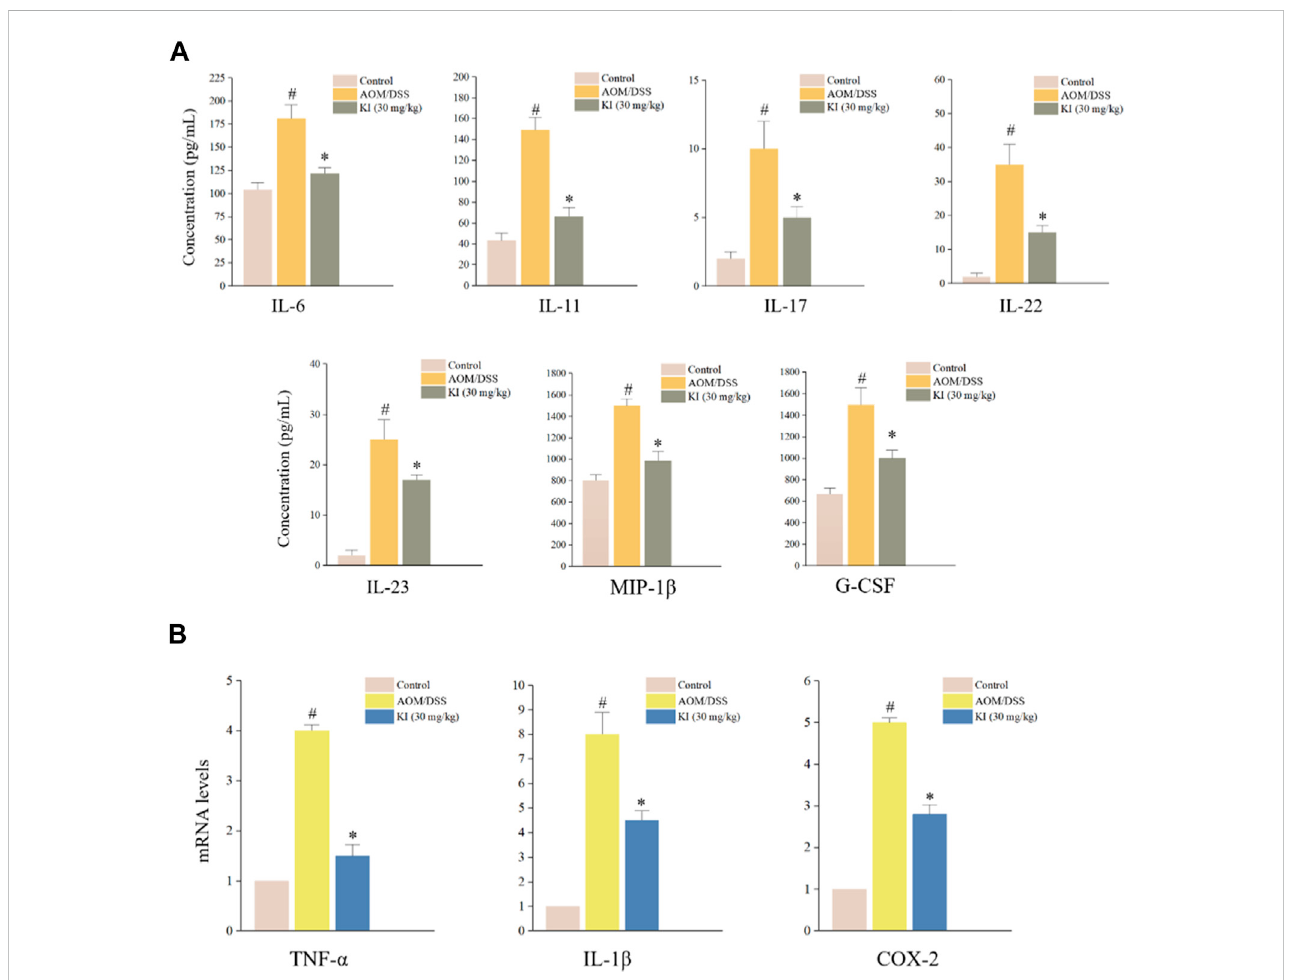
FIGURE 4 In vivo levels of in fl ammatory cytokinesin CAC mice. (A) Results of Bio-Plex Assay or ELISA for indicated gene serum levels in mice at the 10th week (n = 6). (B) Relative levels of TNF- α , IL-1 β , and COX-2 levels in mouse colons at 10th weeks (n = 6) assessed by RT-qPCR. Values are means ± SD from three separate experiments. # p < 0.05 compared with the control group; * p < 0.05 compared with AOM/DSS group.